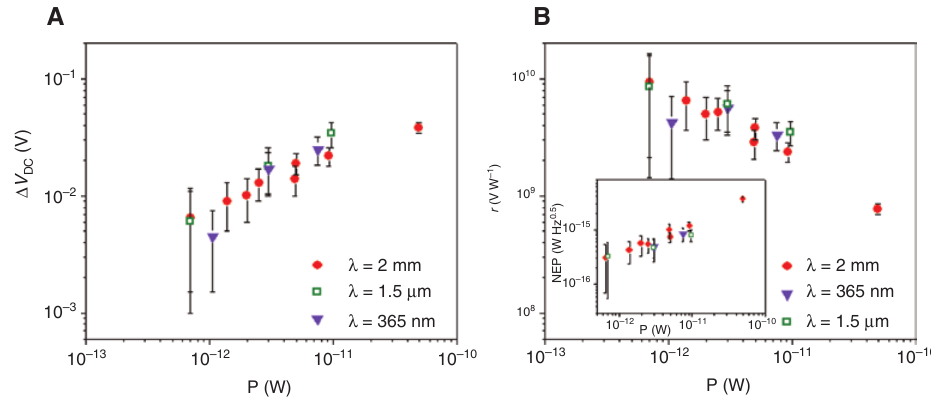
Figure 3: Power dependence of the response. (A) Low power dependence of the response from a 100 nm dot under illumination at different wavelengths. (B) Responsivity as a function of absorbed power at different wavelengths. Inset: calculated electrical NEP as a function of absorbed power at various wavelengths.